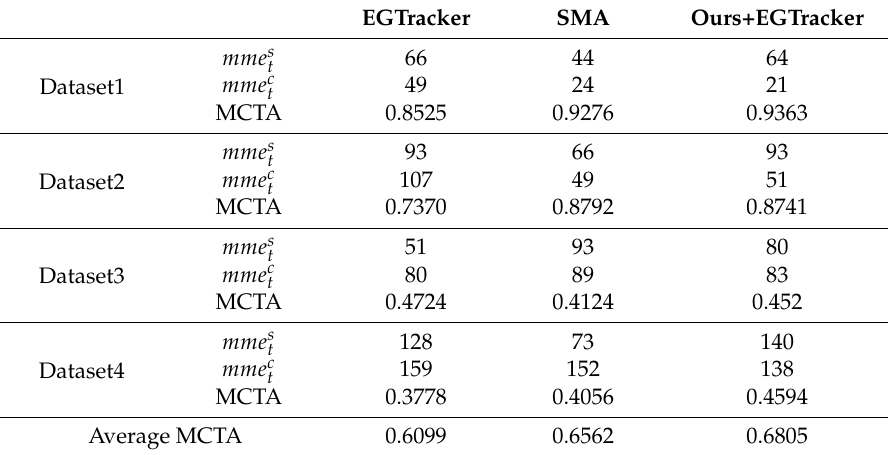
Table 4. Comparison results of three algorithms.